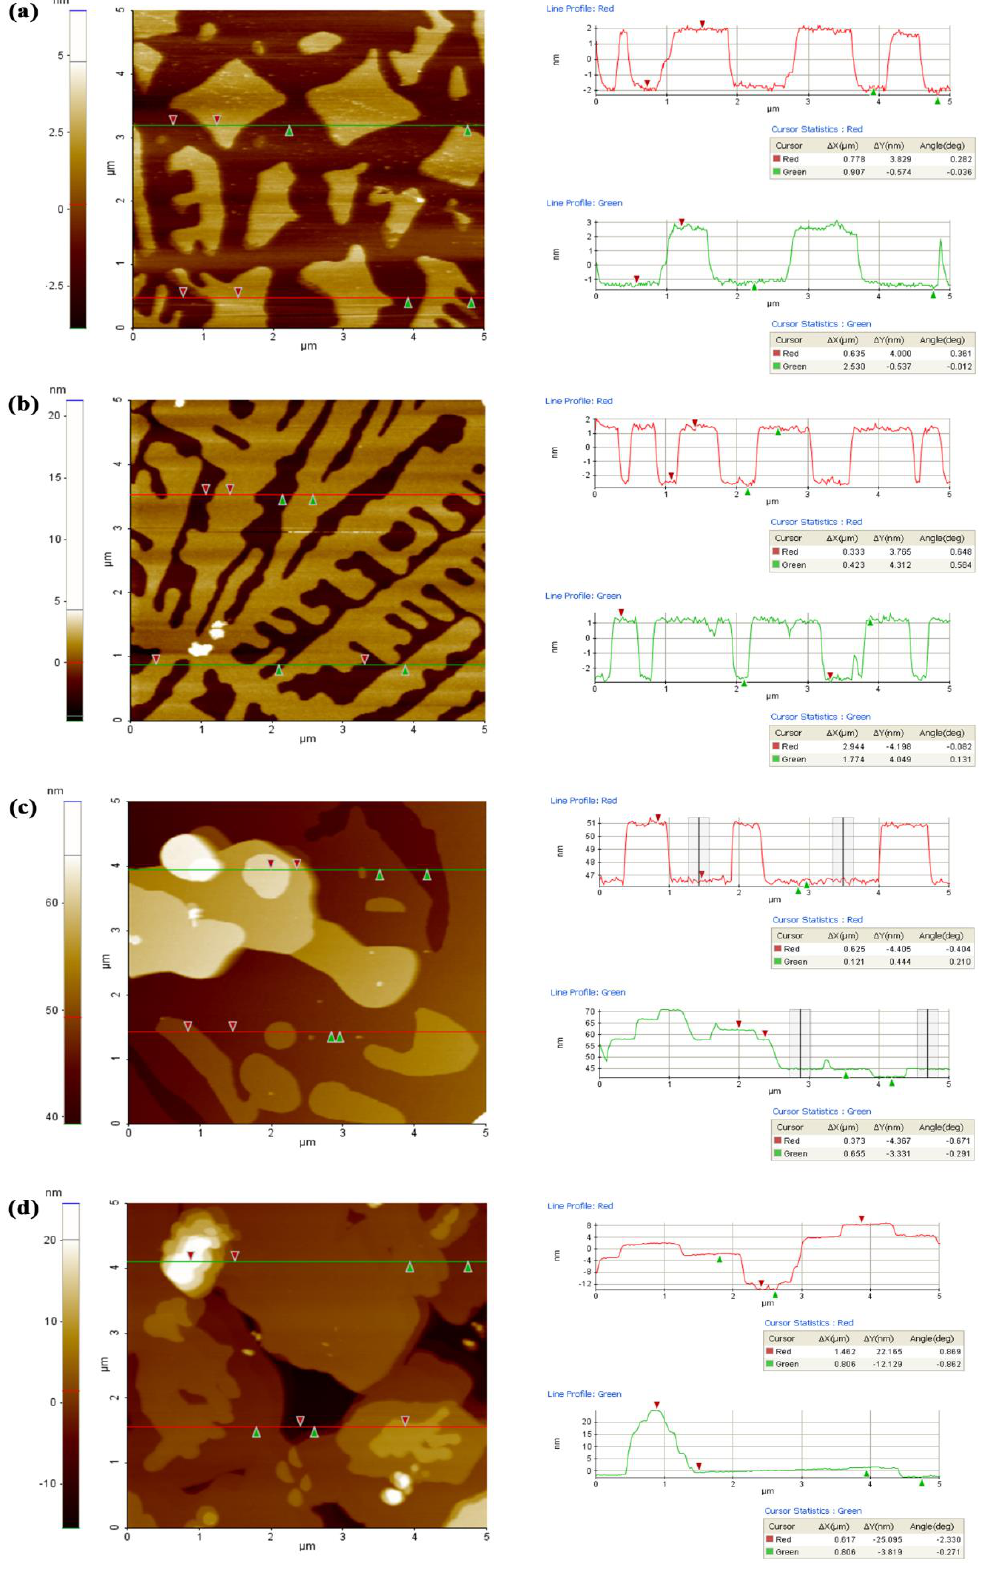
Figure 1. AFM images and two representative profiles isolated from the images of C 32 H 66 thin films deposited with different concentrations on the substrate. ( a ) 0.05% w/v, ( b ) 0.13% w/v, ( c ) 0.3% w/v, and ( d ) 0.5% w/v.